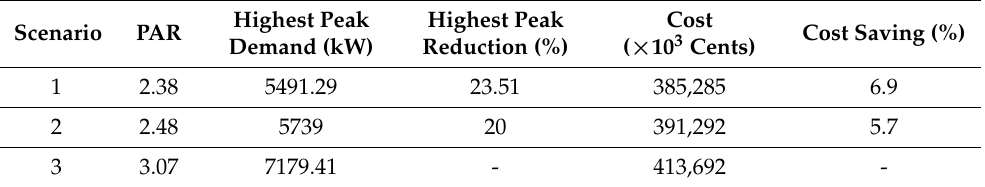
Table 3. Comparison of obtained performance under different schemes in case